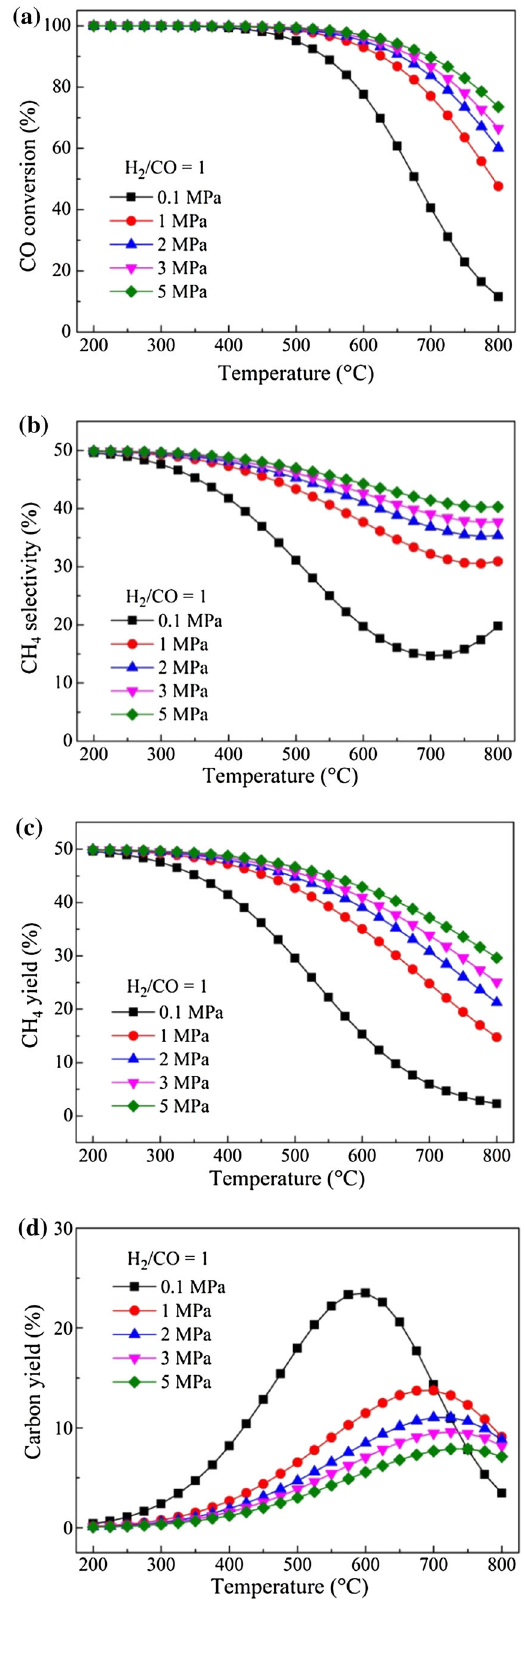
c Fig. 3 Effect of temperature and pressure on catalytic performance.